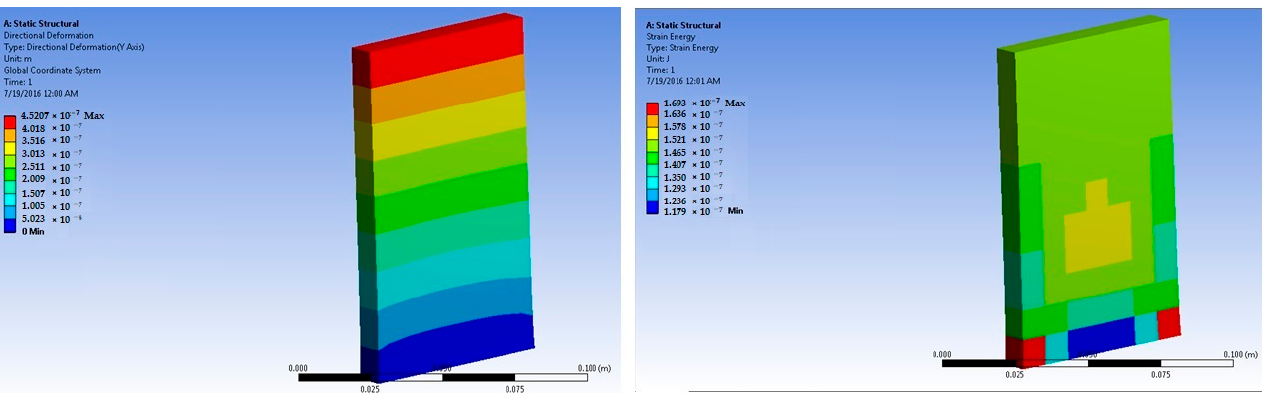
Figure 11. Plain concrete slab at 50 × 10 5 N force (deformation and strain energy). The model for the plain concrete sample predicted a maximum stress of 6.9 × 10 4 Pa and a maximum strain 4.2 × 10 − 6 m/m at 50 × 10 5 N force. The corresponding deformation was 1.36 × 10 − 6 m. These values were quite close to the experimental result.